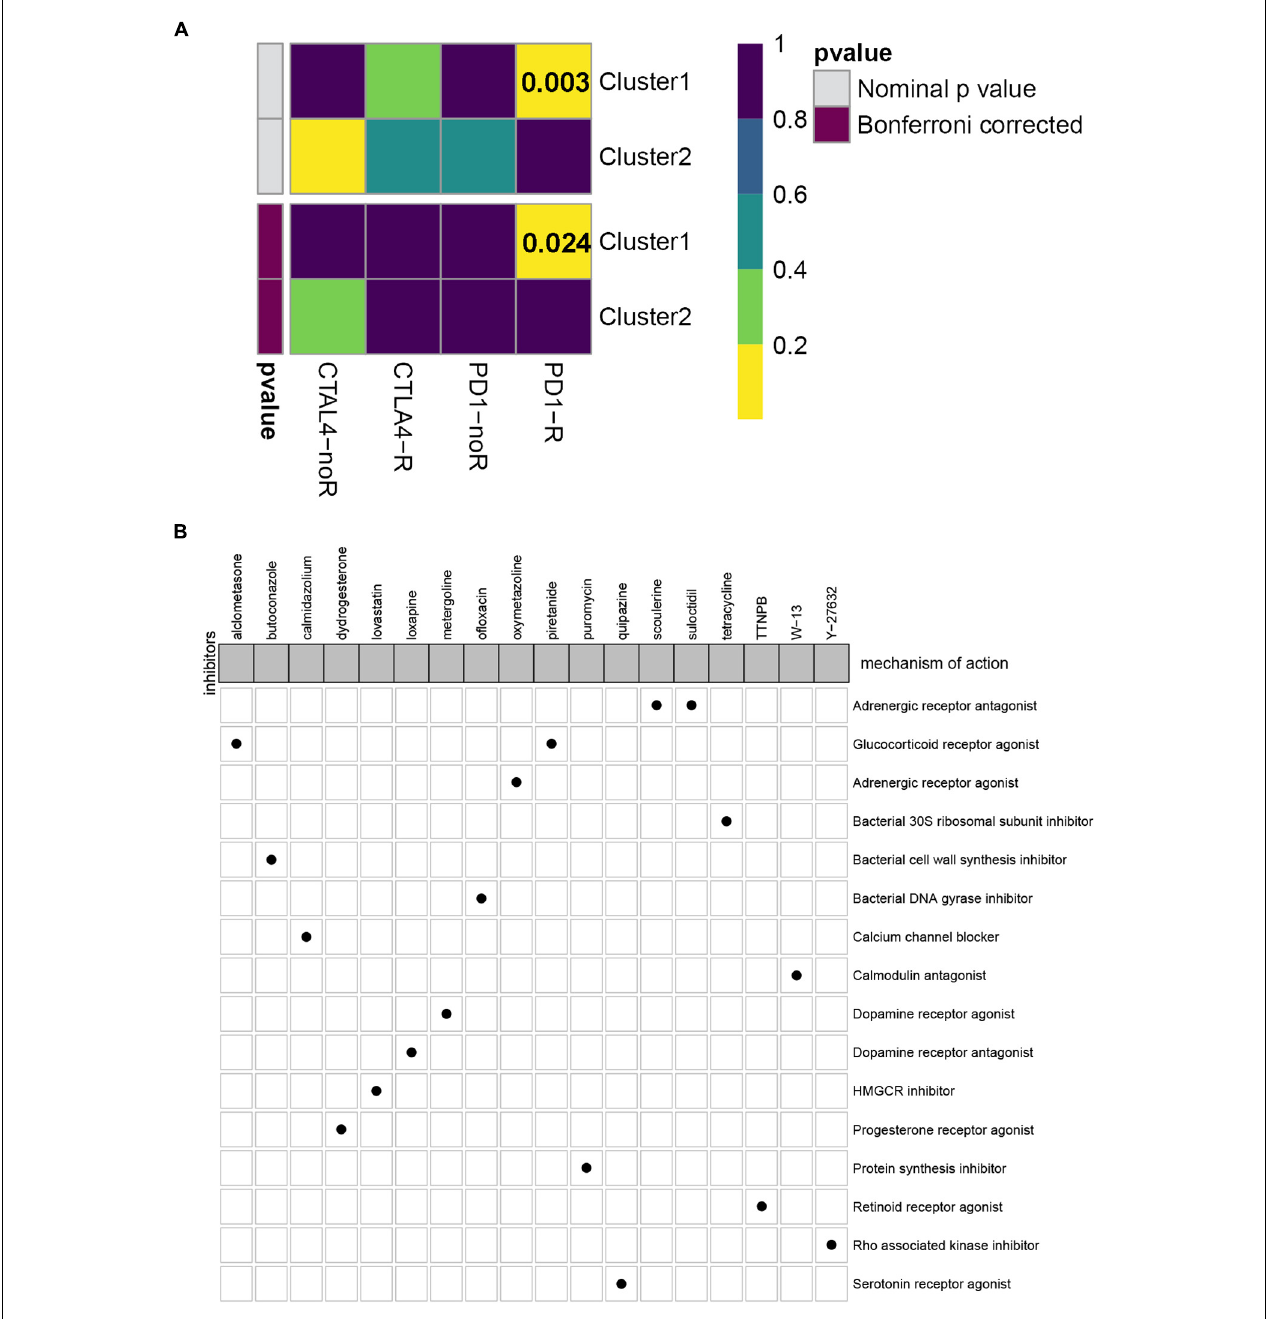
FIGURE 5 | Evaluation of potential compounds and immunotherapy response to the two subtypes. (A) Submap analysis demonstrated that cluster 1 had more sensitivity to the programmed cell death protein 1 inhibitor (Bonferroni-corrected, P = 0.024). (B) CMap database analysis identified candidate drugs targeting the two molecular subtypes based on the